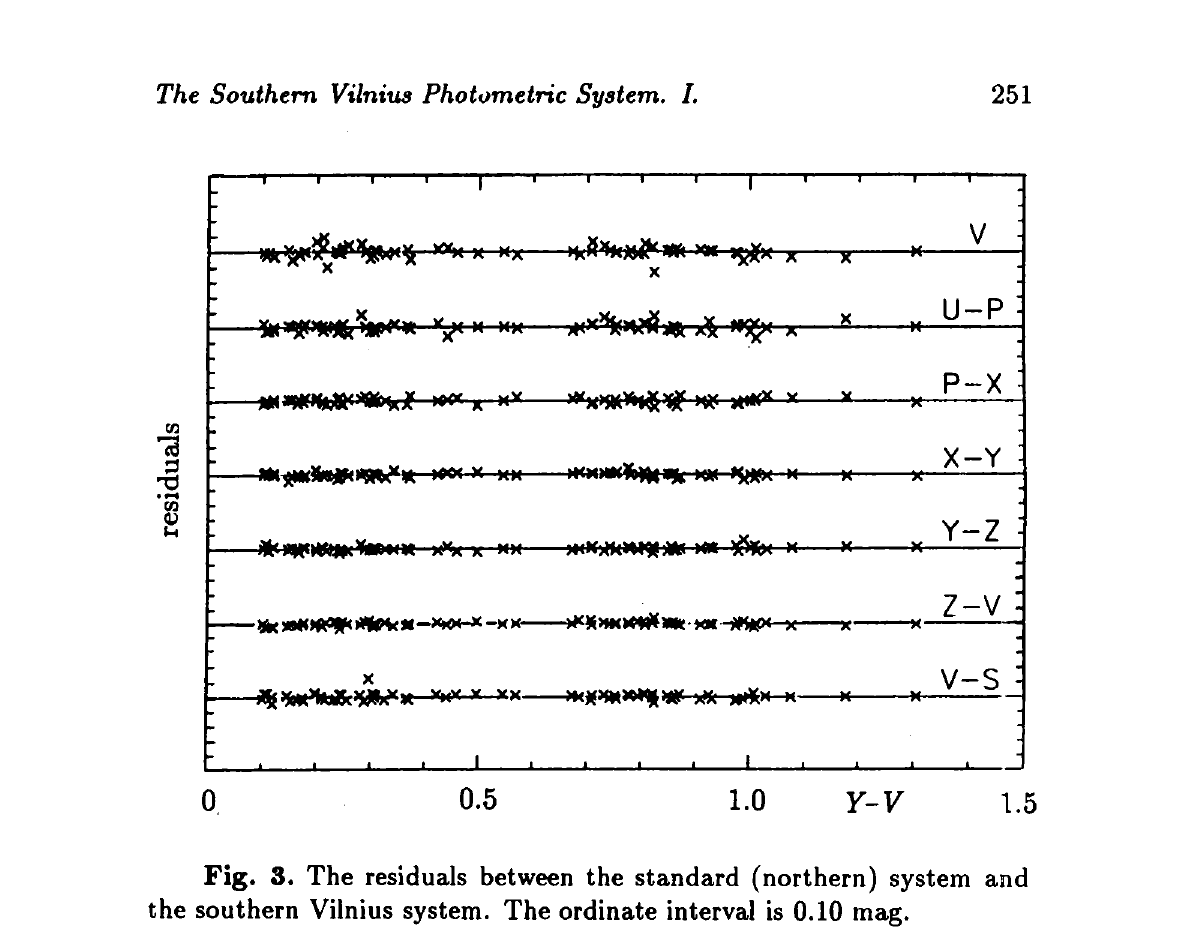
Fig. 3. The residuals between the standard (northern) system and the southern Vilnius system. The ordinate interval is 0.10